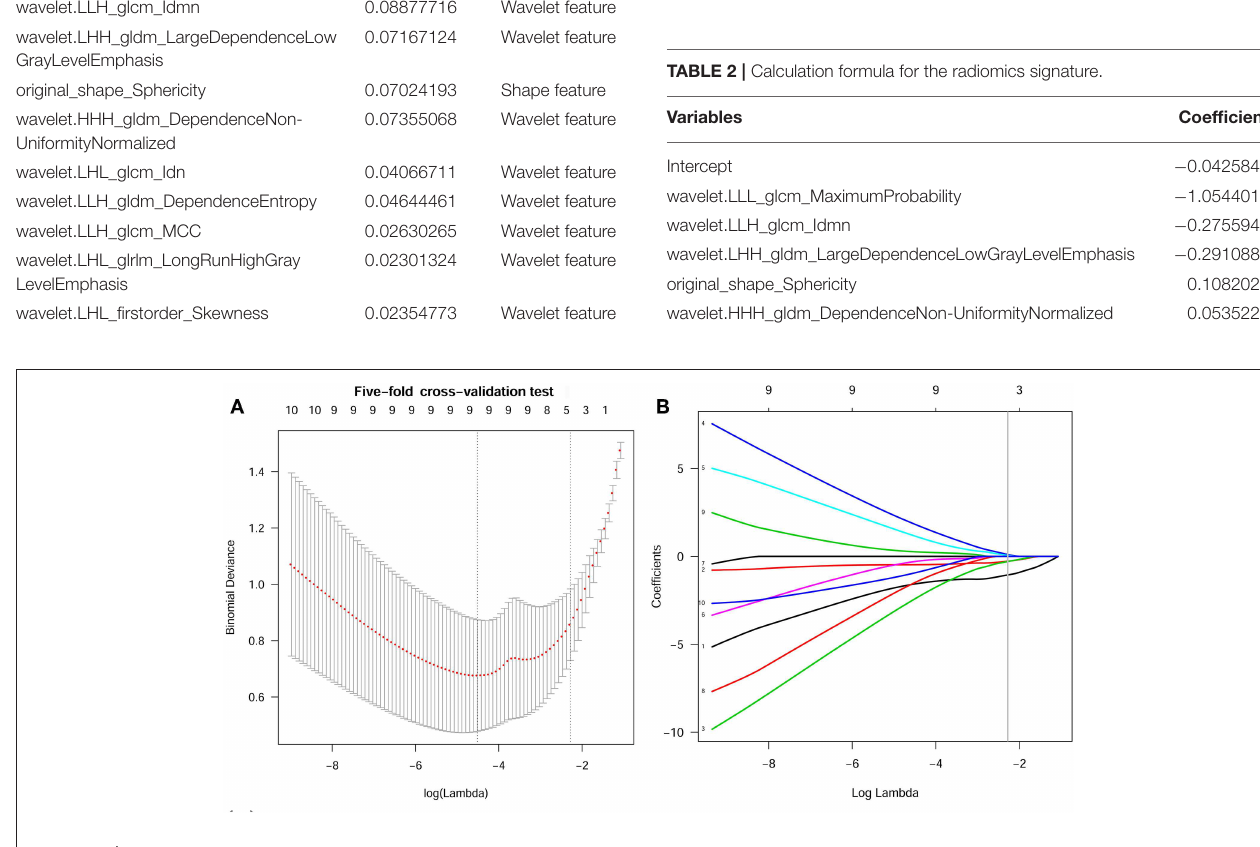
Frontiers in Oncology |